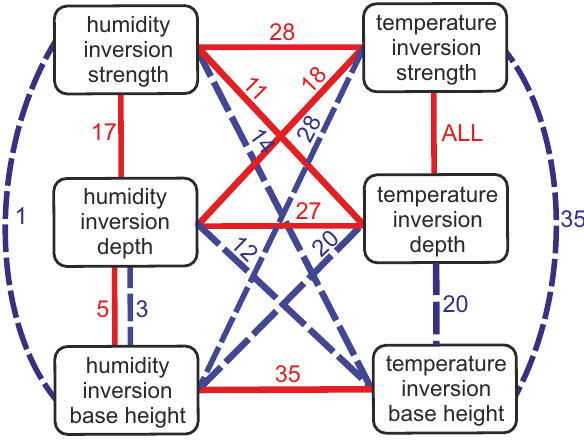
Fig. 9. Schematic presentation of temporal correlation between hu- midity inversion and temperature inversion properties (only the strongest humidity and temperature inversion in a profile are con- sidered). The red solid lines indicate a significant positive correla- tion, and blue dashed lines a significant negative correlation (corre- lation coefficient − 0.20< r >0.20, p <0.01). The numbers denote the amount of stations at which the correlation was